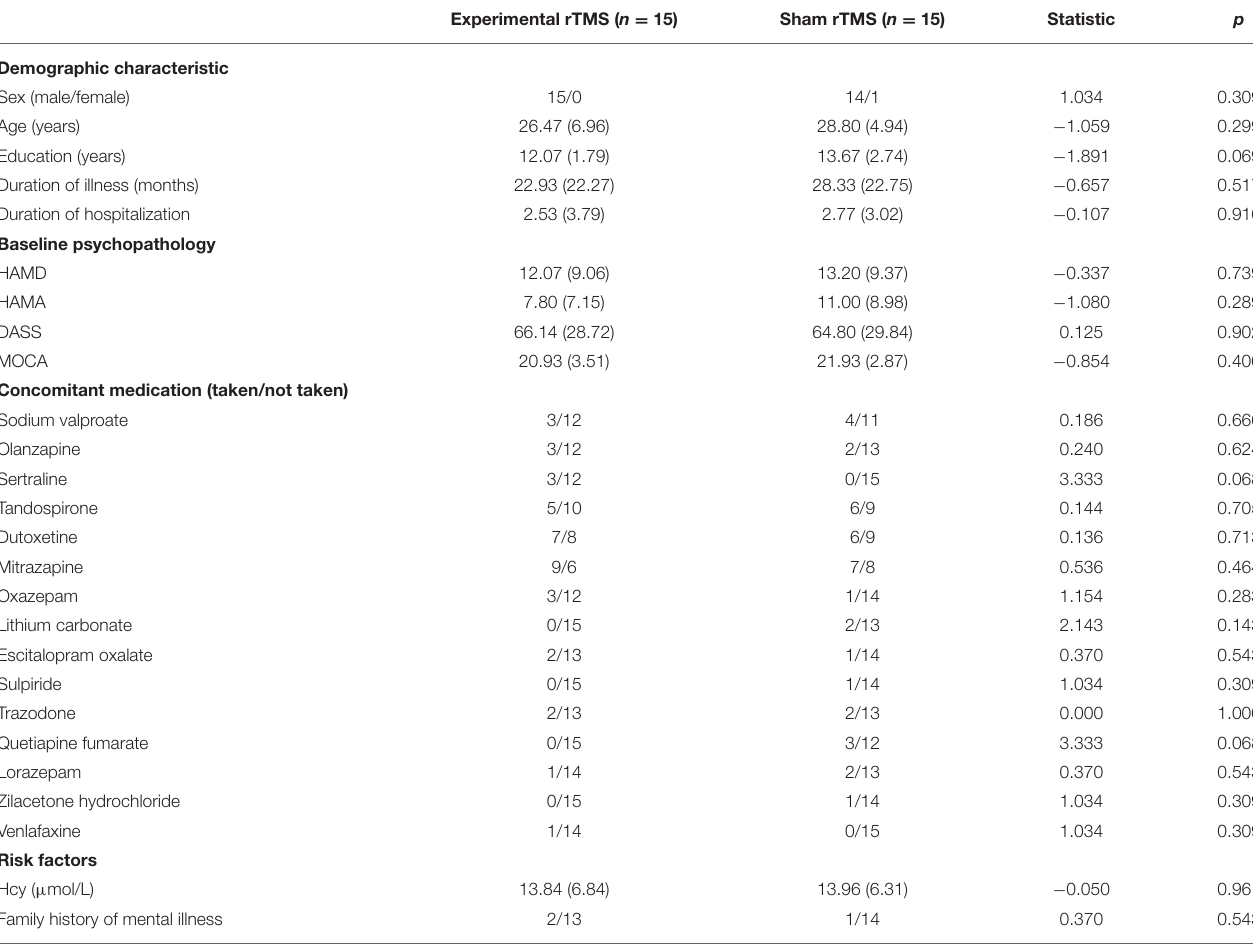
TABLE 1 | Clinical and socio-demographic information of study participants. Experimental rTMS ( n = 15) Sham rTMS ( n = 15) Statistic